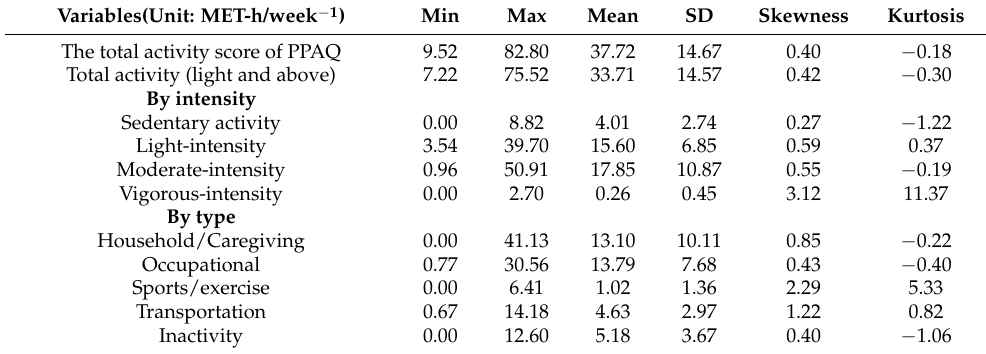
Table 2. Average scores on the Serbian version of PPAQ 1 according to domains in MET 2 .